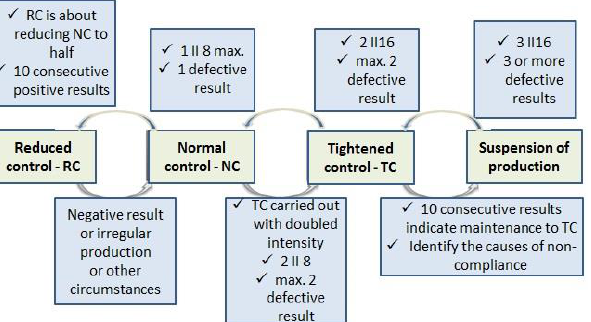
Figure 12. Transition conditions between the levels of control plans for assessing characteristics other than strength for concrete curbs (EN 1340:2004 [16]).